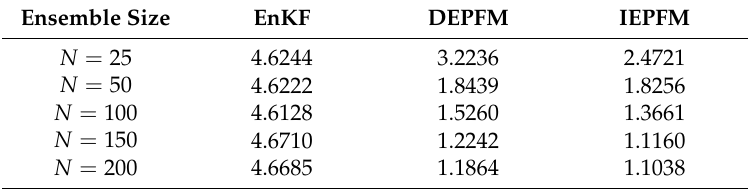
Table 1. Comparison of REMS for the Lorenz96 model.